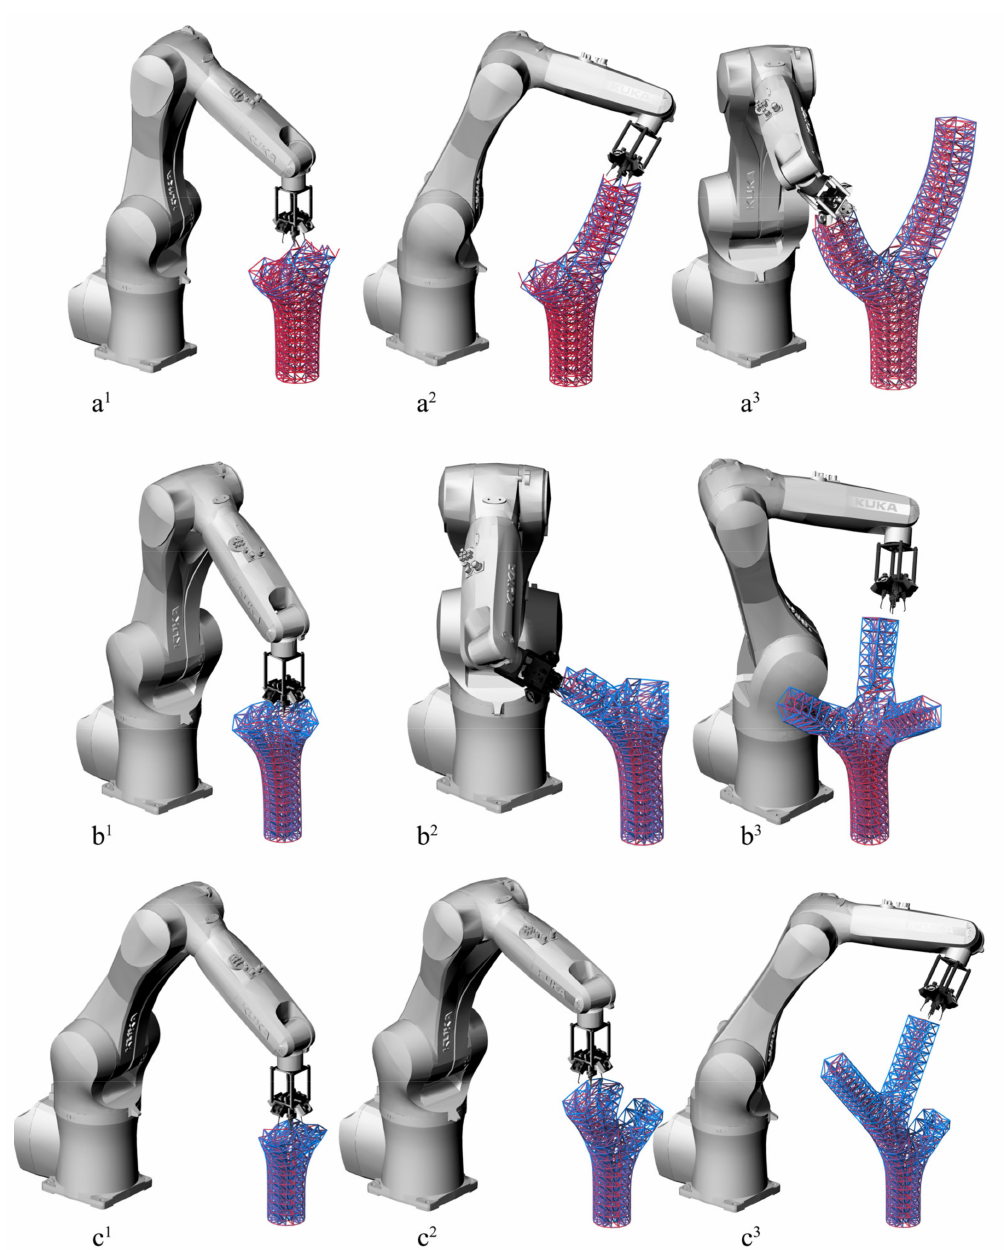
Figure 12. Printing process simulation: ( a ) two-branch geometry; ( b ) multi-branch geometry; ( c ) multi-level-branch